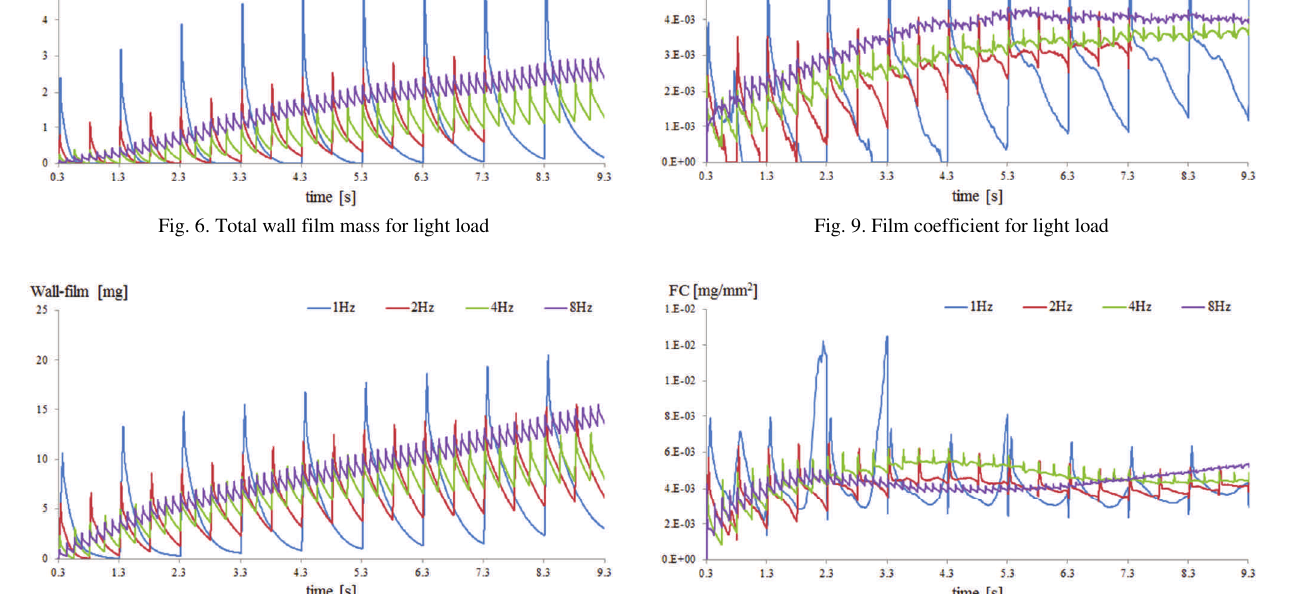
Fig. 5. Total wall film mass for idle load